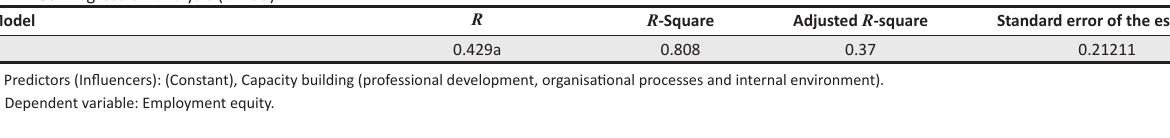
TABLE 5b: Analysis of variance (ANOVA). Model